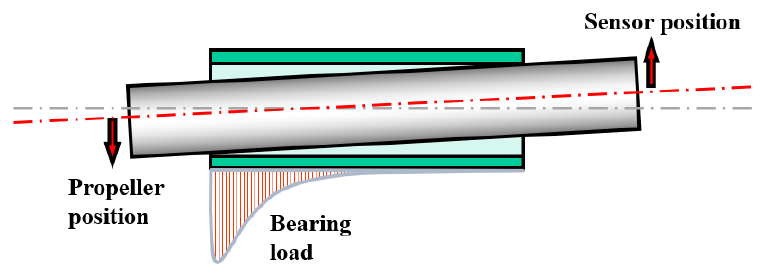
Figure 24. Rigid beam